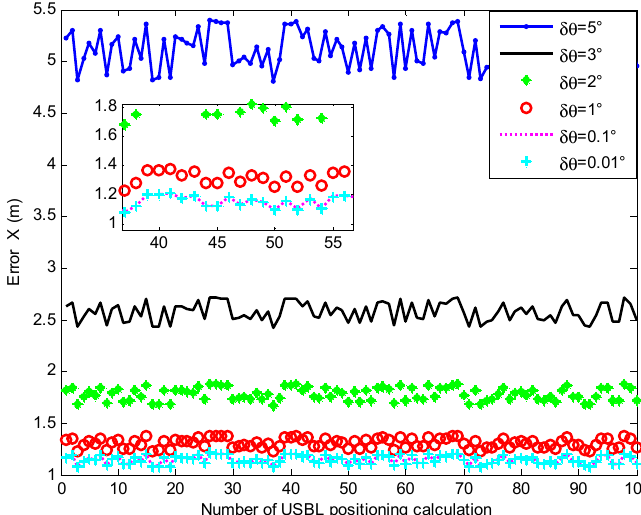
Figure 17. The influence of rotation angle error on USBL horizontal positioning accuracy.